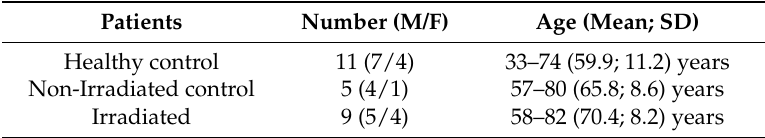
Table 1. Demographic data of 25